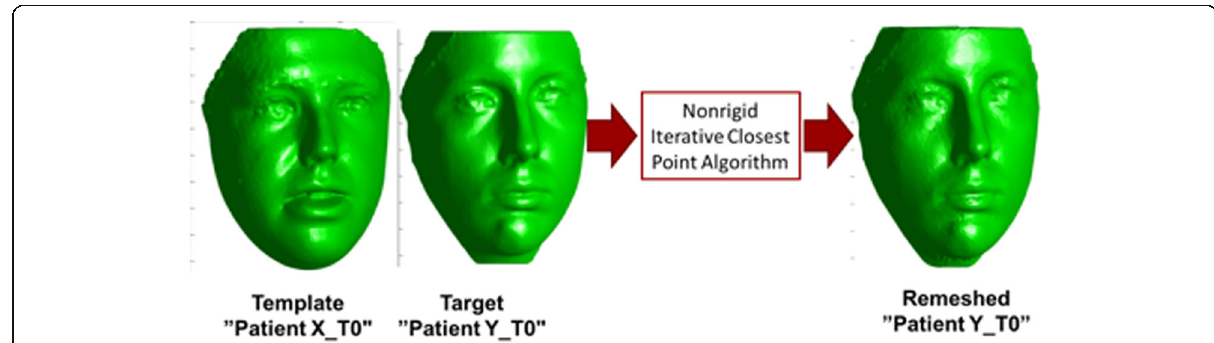
Fig. 5 Illustration of how to establish vertex correspondence between meshes. Template mesh is being remeshed (deformed) to match the target face (mesh) using non-rigid ICP. Remeshed face (on the right) is now representing the target mesh and it will be in vertex correspondence with the original